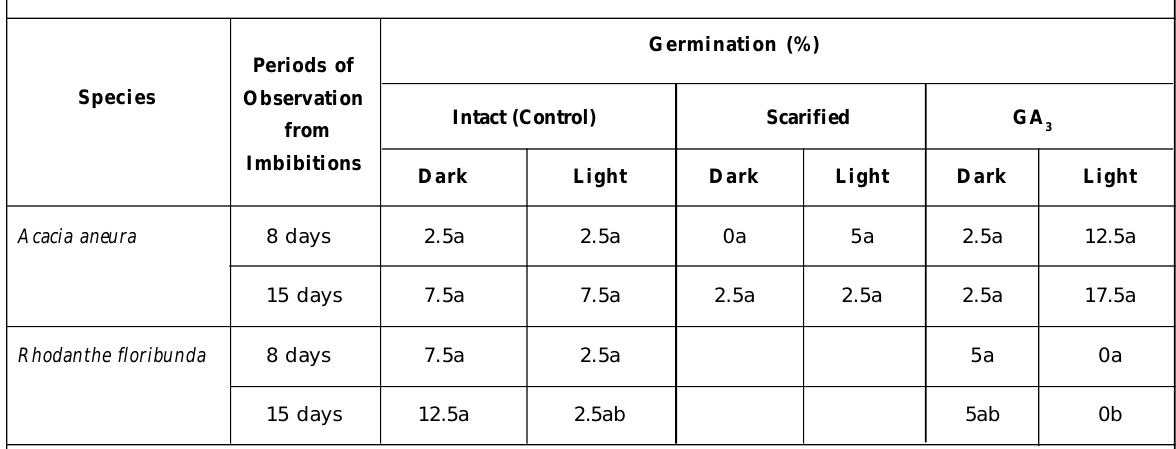
Table 3: Seed contamination rate at 8 and 15 days from imbibition of two Australian native species